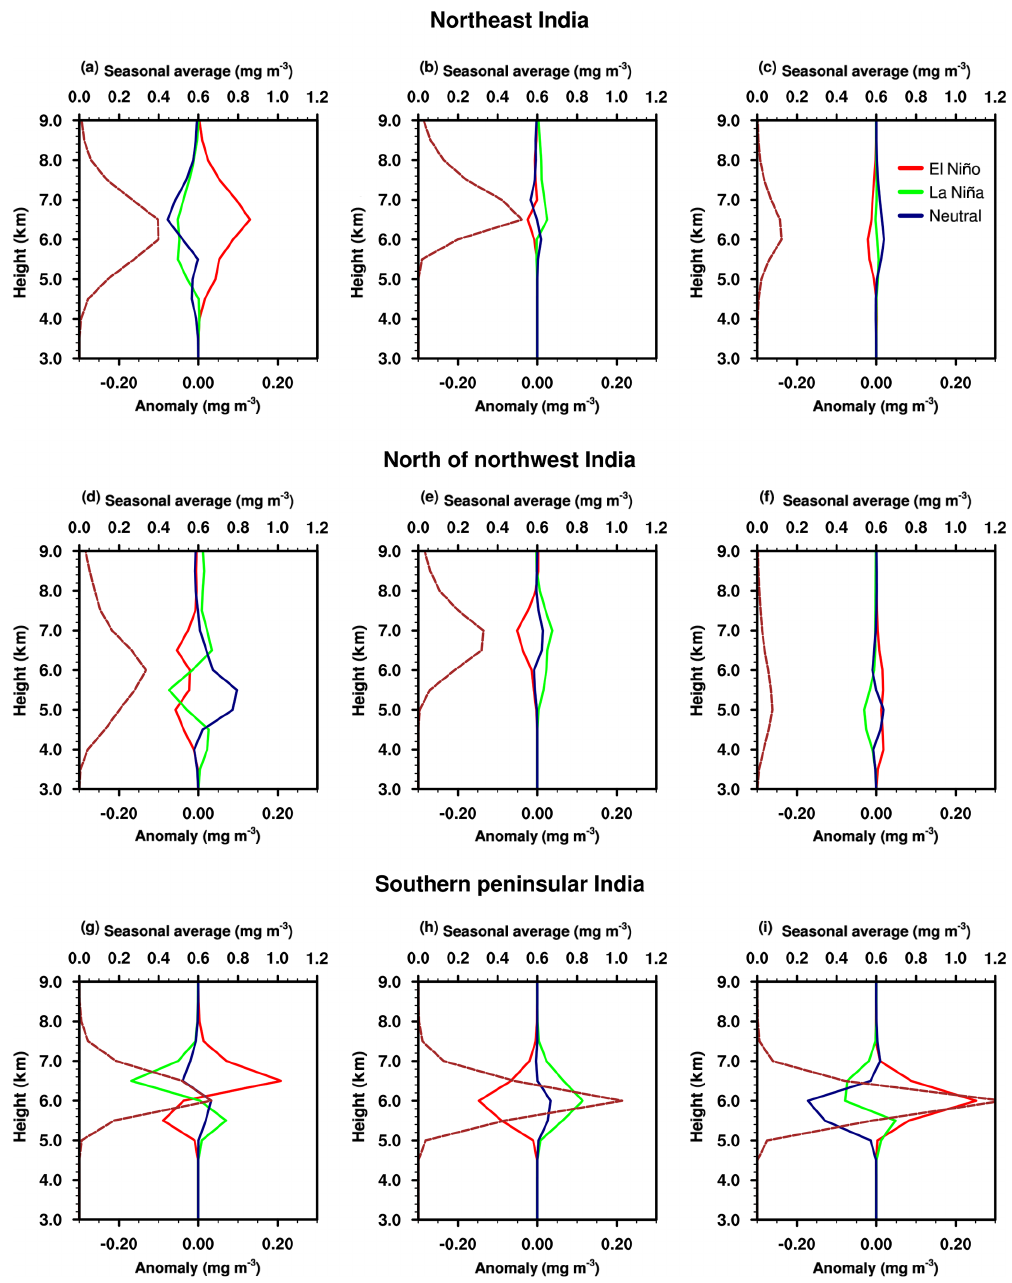
Figure 6. Seasonal average (brown dotted curve) and anomaly composite of snow concentration during different ENSO phases. (a, d, g) Premonsoon season. (b, e, h) Monsoon season. (c, f, i) Postmonsoon